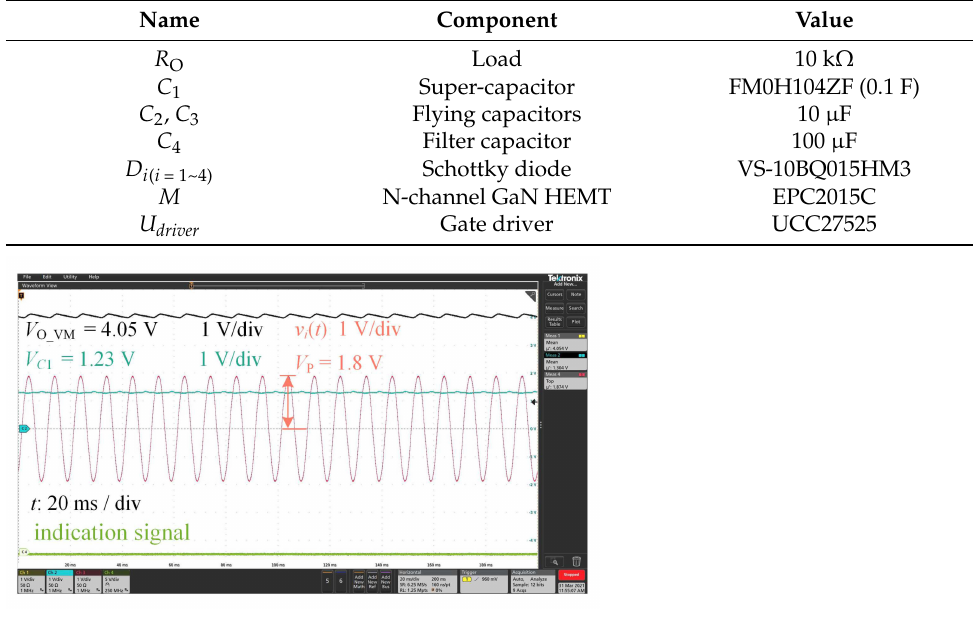
Figure 15. Steady state operation of VM mode under vibration with a vibration frequency of 100 Hz and an acceleration of 0.7 g.